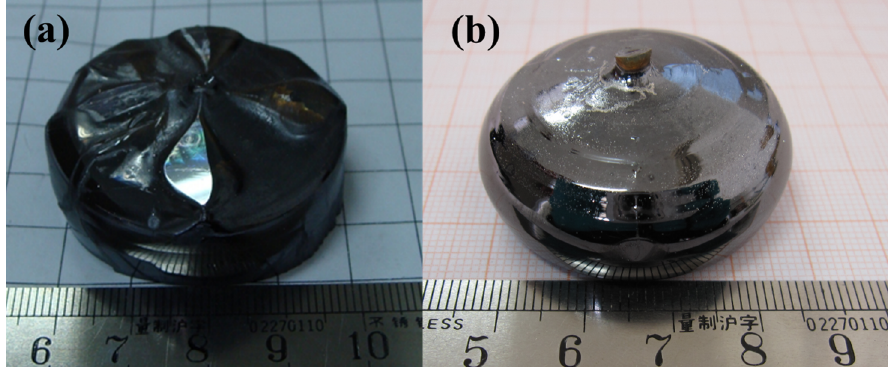
Figure 14. (Color online) Photos of Mn-doped NBT-BT single crystals and samples ( a ) grown using <001> oriented seed (Mn:NBT-BT) and ( b ) grown using Pt wire as seed [Mn:NBT-BT]. Reprinted with permission from [29]. Copyright 2009 AIP Publishing LLC.